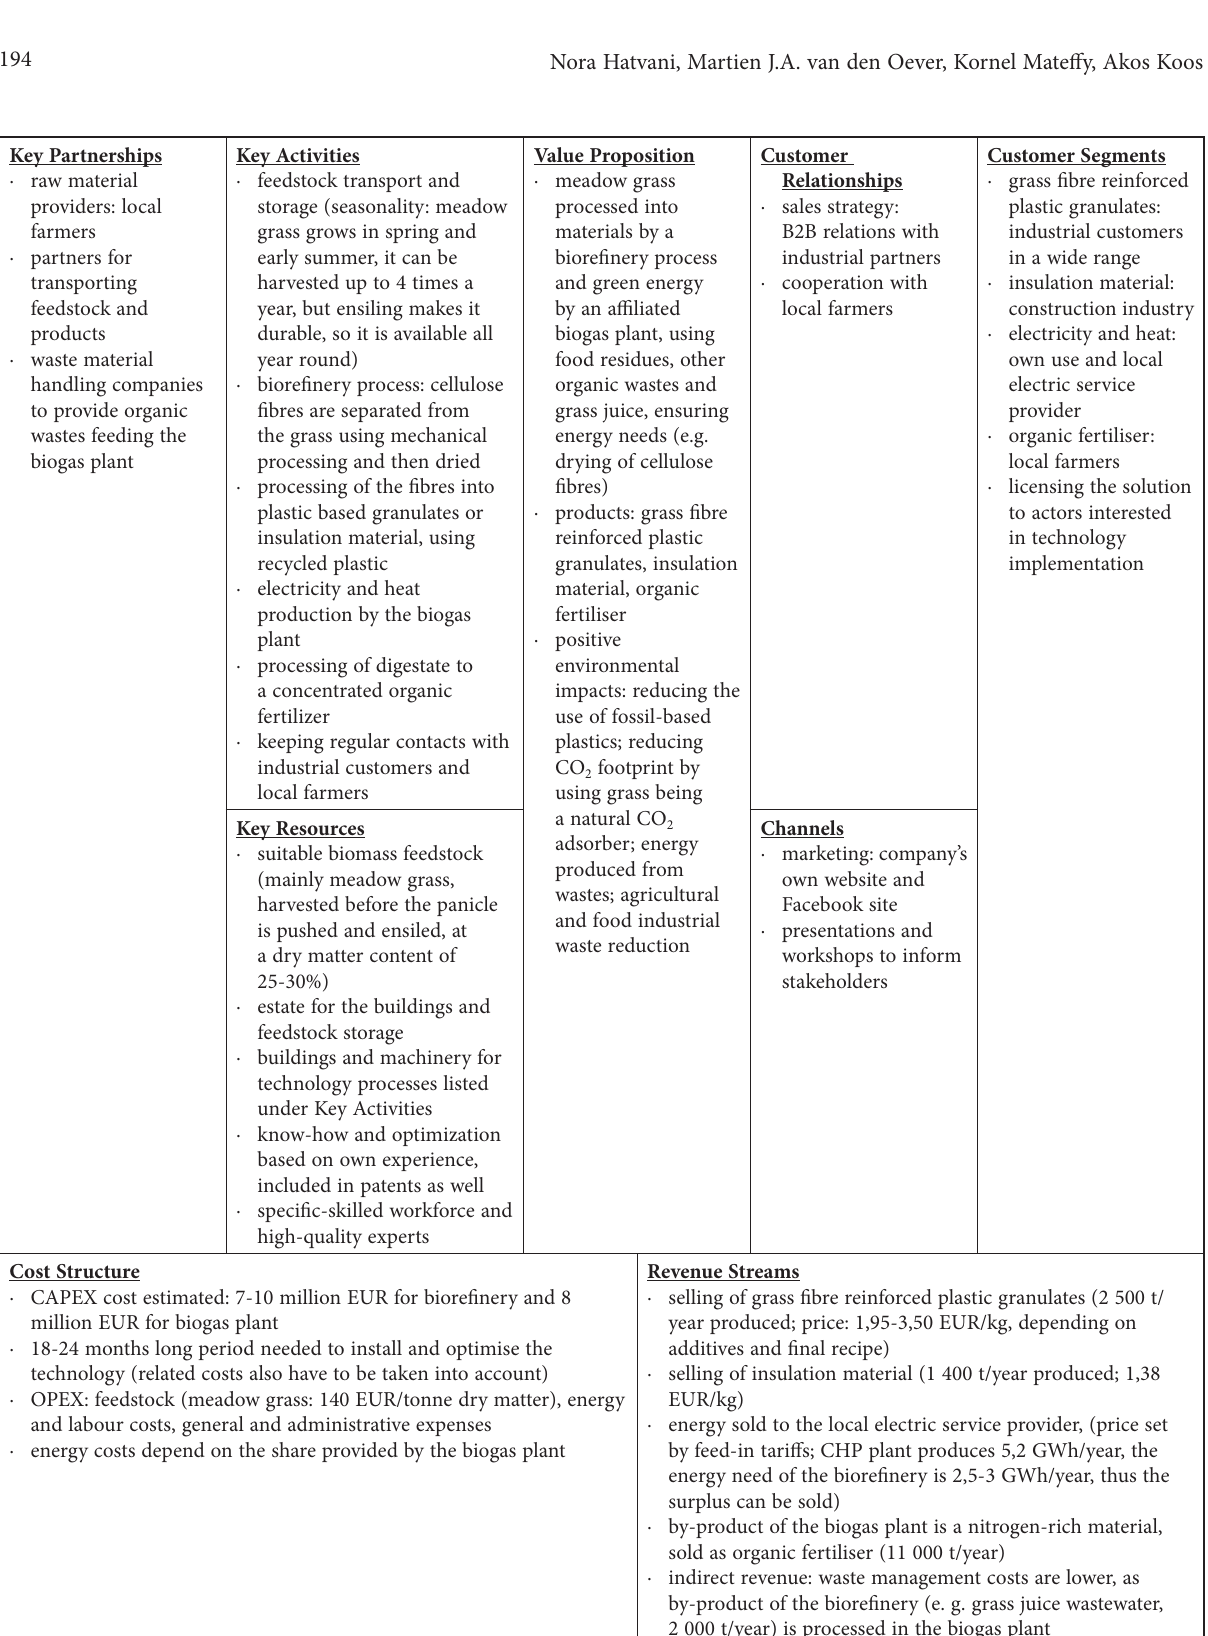
Figure 6. BMC of solution ‘S4’ (Biowert,